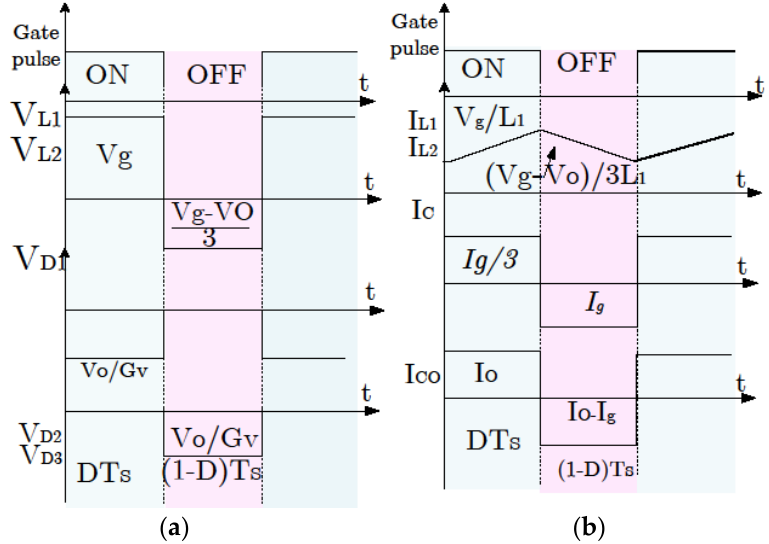
Figure 4. Key waveforms of HSIVL converter: ( a ) Voltage waveforms and ( b ) current waveforms.